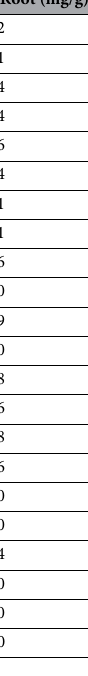
Table 1. Composition of ginsenosides in black ginseng (BG). *Sum of individual ginsenoside content.